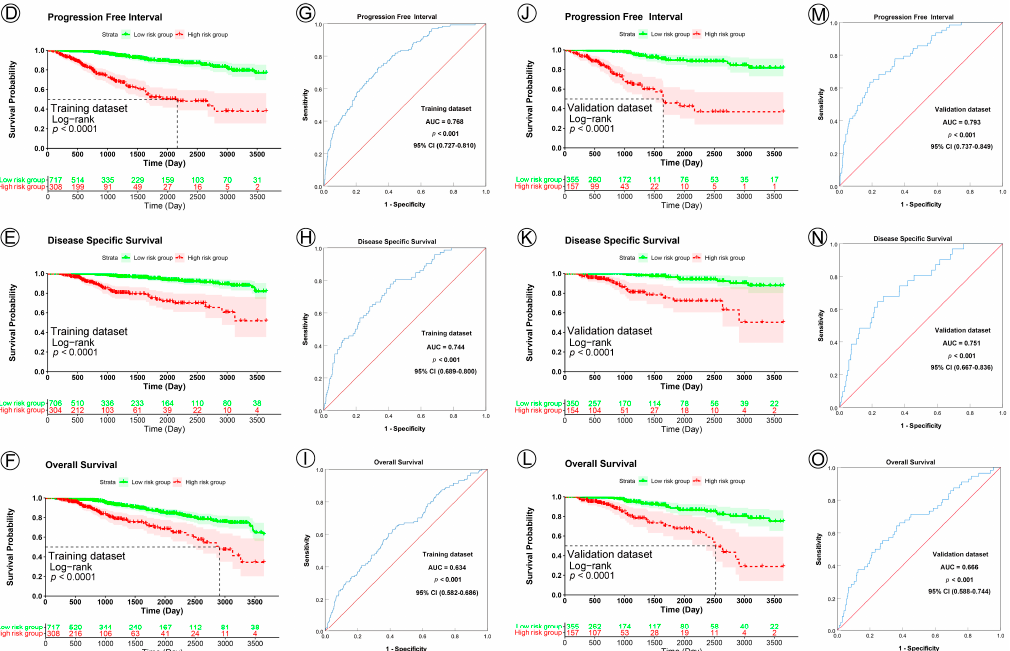
Figure 3. Construction of a 56-gene prognostic signature for BC based on pyroptosis-related DEGs. ( A ) A forest plot of multivariable Cox regression analyses. ( B ) The distribution and survival status of BC patients with different risk scores. The blue and red dots represent clinical events or no clinical events. ( C ) A vioplot of the 56-gene signature in the two risk groups. ( D – F , J – L ), KM curves of PFI, DSS, and OS for high- and low-risk groups in the training and validation datasets. ( G – I , M – O ), ROC analysis shows the sensitivity and specificity of the 56-gene signature for predicting PFI, DSS, and OS for high- and low-risk groups in the training and validation datasets.